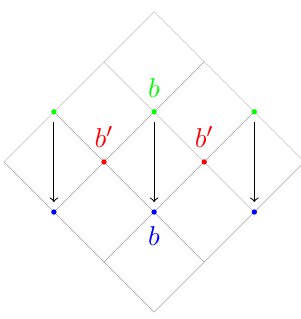
Figure 14 . The Hodge-Deligne diamond of type II b with its decomposition into primitive parts (4.44). The action of N (cid:0) are labelled by arrows, and we use colours to highlight the primitive 1 subspaces P 3 ( N (cid:0) ), P 4 ( N (cid:0) ) and their images under the action of N (cid:0) . Since the two sl (2)-triples 1 1 1 are commuting, the primitive subspaces P 3 ( N (cid:0) ), P 4 ( N (cid:0) ) and their images under N (cid:0) are preserved 1 1 1 by N (cid:0) . 2